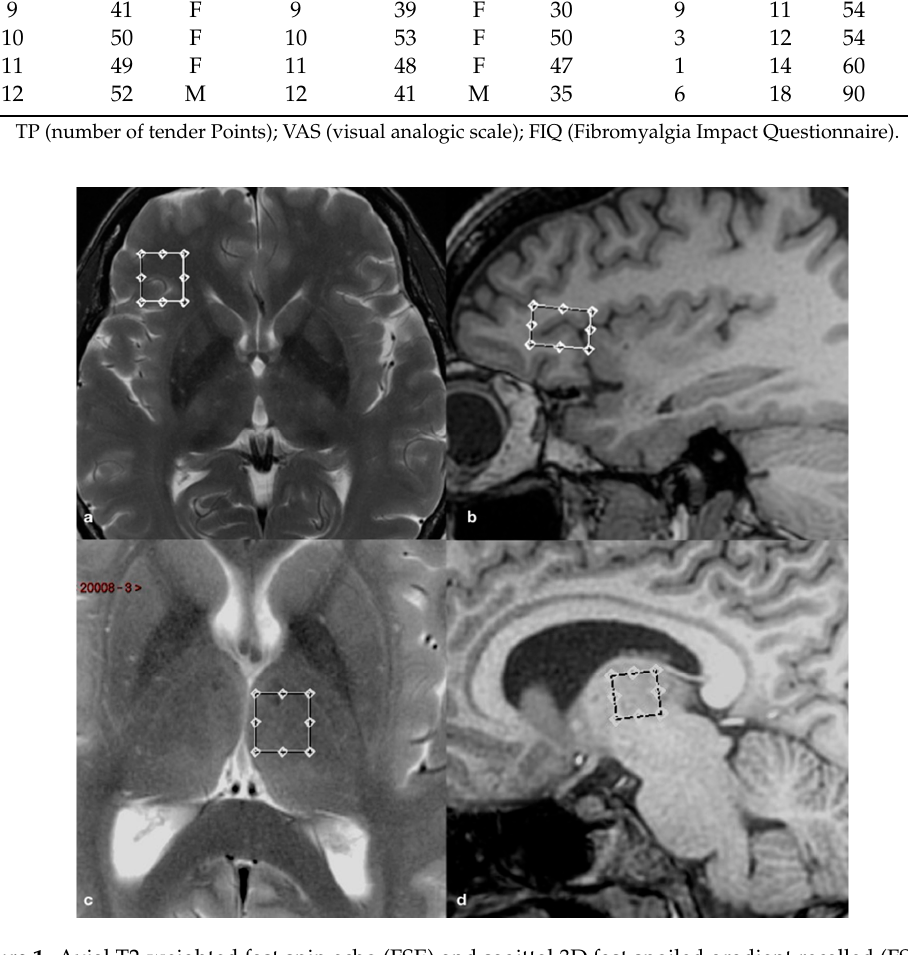
Figure 1. Axial T2-weighted fast spin echo (FSE) and sagittal 3D fast spoiled gradient recalled (FSPGR) images showing voxels of interest (VOIs) placement in the right ventrolateral prefrontal cortex (VLPFC) ( a , b ) and left thalamus ( c , d ).